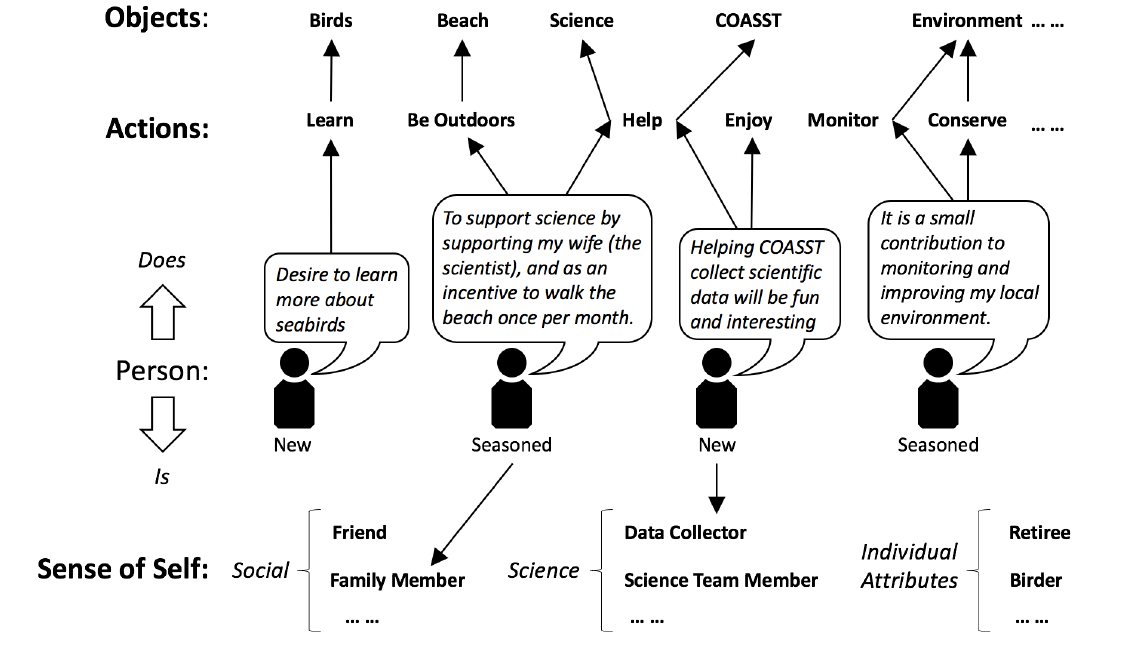
Fig. 1 . Coding schema for person-object theory of interest presented diagrammatically with example quotes from four actual Coastal Observation and Seabird Survey Team (COASST) participants: two from new participants (attended training) and two from seasoned participants (1 year plus of data collection). Sense-of- self codes are categorized into three overlapping identity codes: social identity, science identity, and individual attributes (see Fig. 4). Actual coding is shown by black arrows. Not all participants articulated objects, actions, and/or sense of self, respectively. Ellipses indicate additional codes omitted for visual clarity (see Figs. 2 and 4 for full list and Appendix 2 for